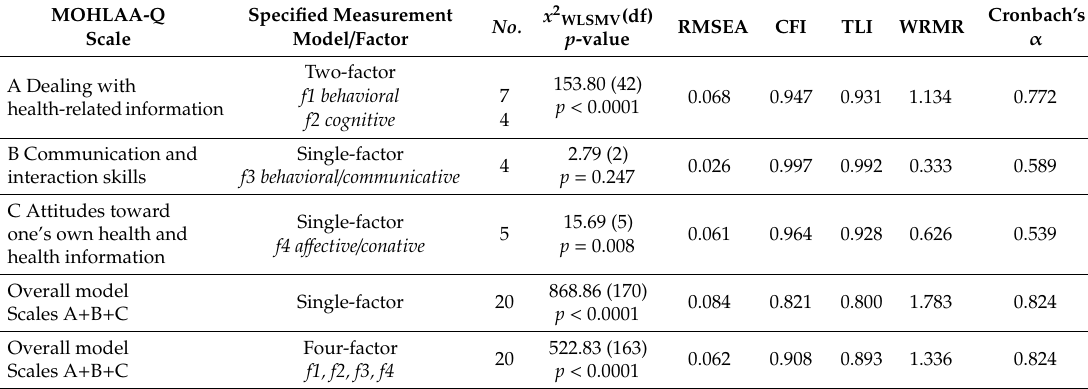
Table 4. Results of the confirmatory factor analysis ( n = 577) for scales A–C and the overall